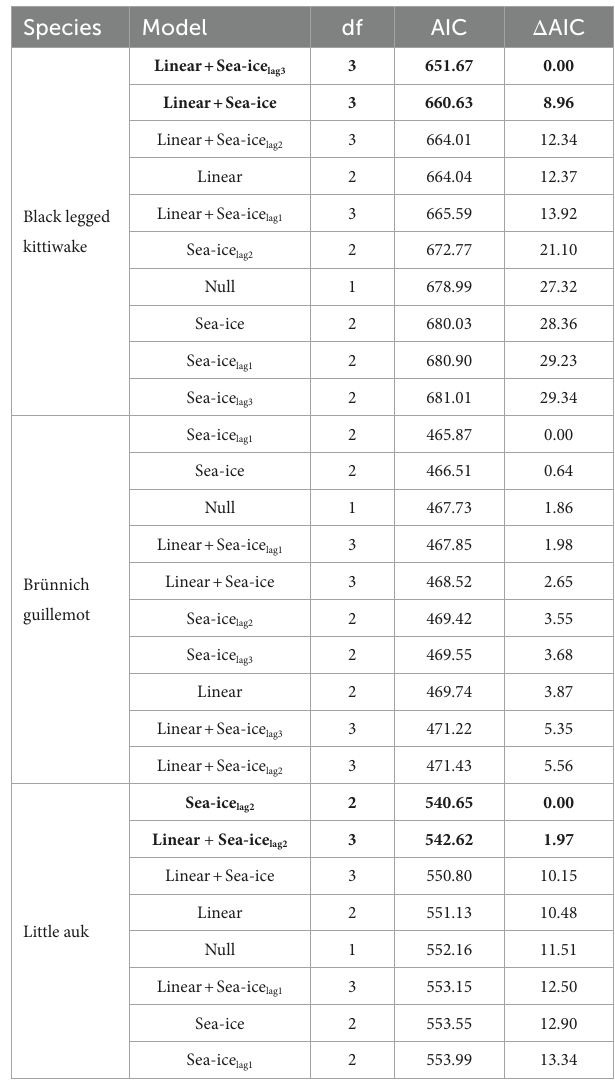
TABLE 2 Results of the model testing for the effect of sea-ice concentration with and without time-lag on breeding success of Brünnich guillemot, black legged kittiwake, and little auk breeding in west Svalbard, over the study